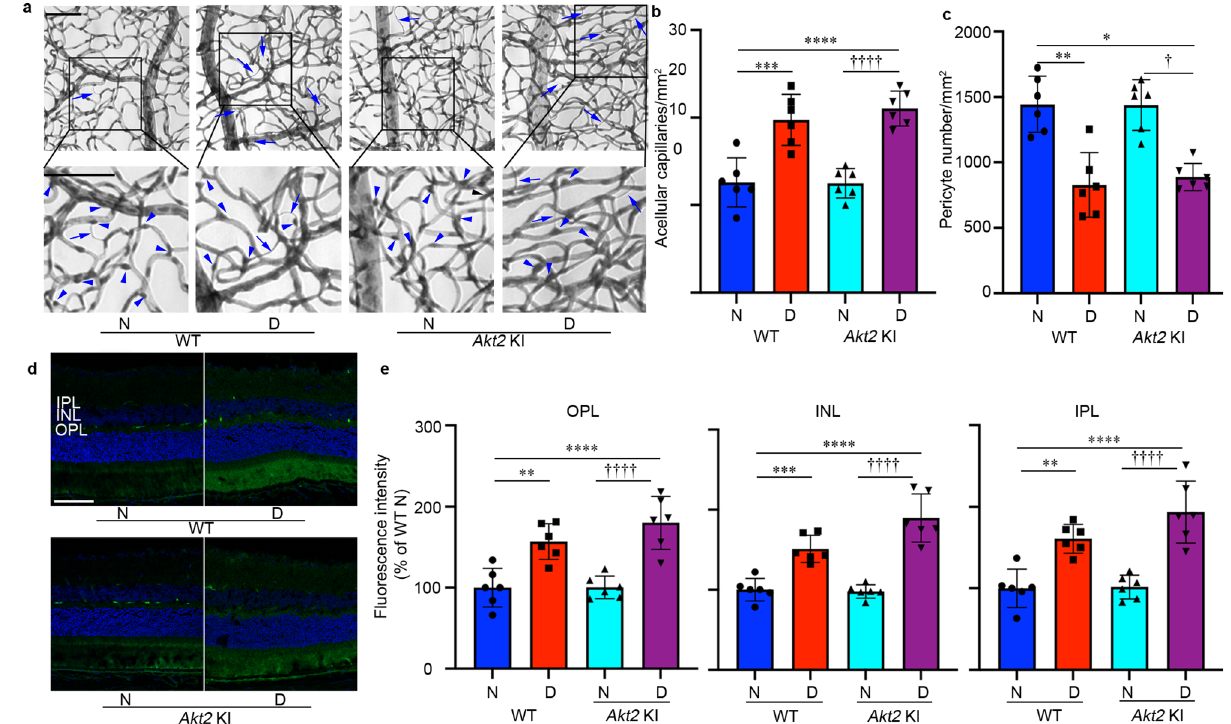
Fig. 7 | RPE-speci fi c Akt2 KI does not in fl uence the development of diabetes- induced retinal vascular lesions. a Representative micrographs of retinal vessels from diabetic mice (8 months of diabetes) and age-matched nondiabetic mice. Scalebar:100 µ m.Arrowsindicatedegeneratedcapillariesandarrowheadsindicate capillarypericytes. b Diabetesincreasedthenumberofdegeneratedcapillariesand ( c ) decreased the number of retinal capillary pericytes in diabetic WT mice com- paredtonondiabeticanimals.Therewasnosigni fi cantdifferenceinthenumbersof acellular capillaries and pericytes in the retina between diabetic WT and diabetic Akt2 KI mice. d Representative micrographs of retinal sections from each group after mice were intravenously injected with FITC-albumin. Scale bar: 100 µ m. e Average fl uorescence intensity was quanti fi ed from a large area of INL, IPL, and OPL,excluding obvious microvessels. Diabetes-induced accumulation of FITC-BSA in these retinal layers was higher in WT and Akt2 KI diabetic mice (8 months